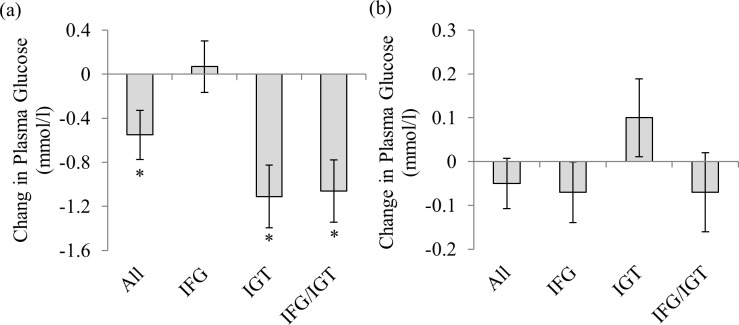
(a) Changes in 2-hour oral glucose tolerance from baseline after 12-weeks of resistance training in the pooled sample (All), participants with impaired fasting glucose (IFG), participants with impaired glucose tolerance (IGT), and participants with IFG/IGT. * p<0.001 vs. baseline. (b) Change in fasting glucose from baseline after 12-weeks of resistance training for the pooled sample. Error bars show standard error.